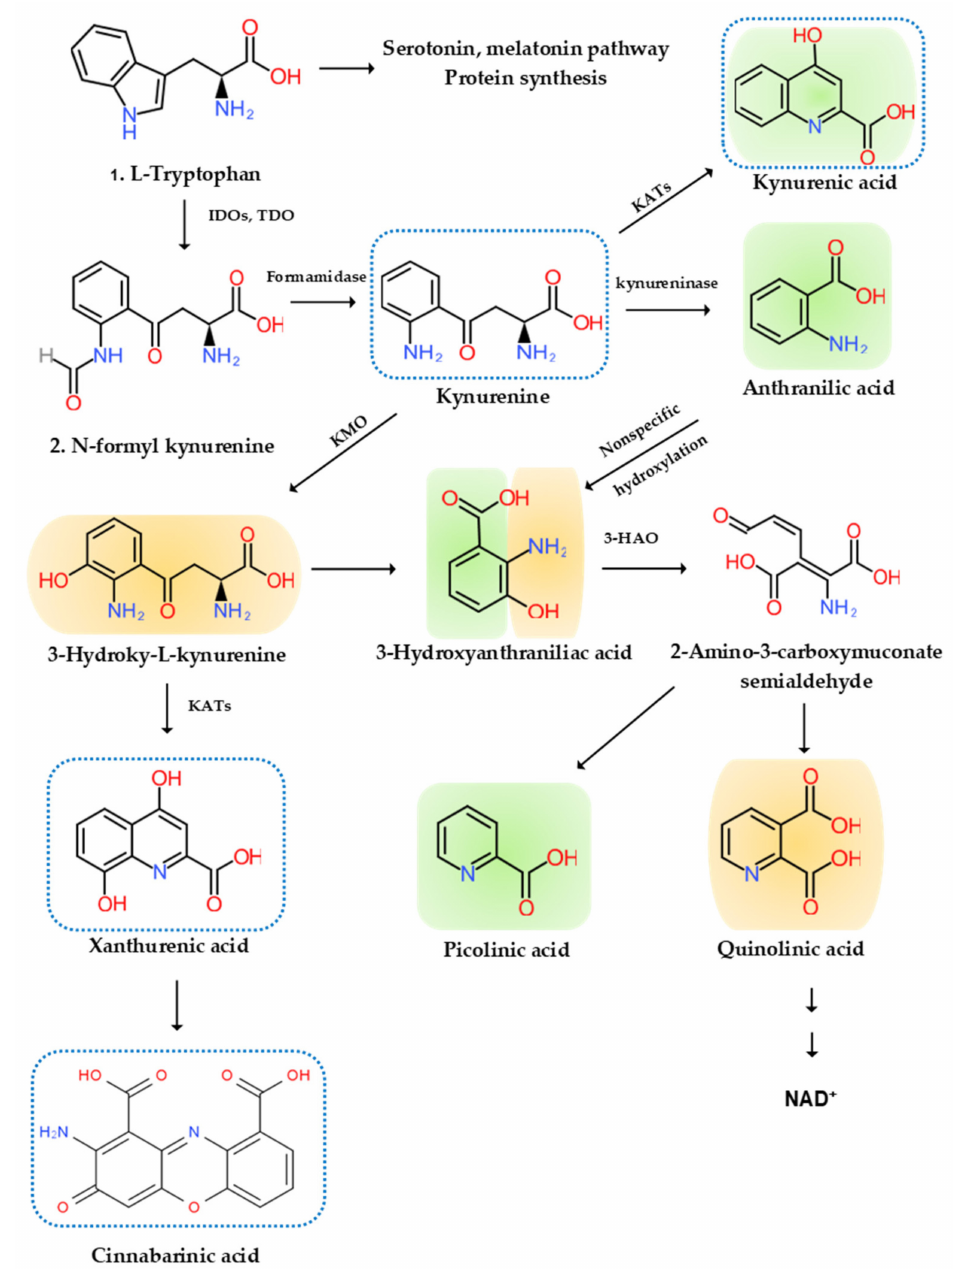
Figure 2. l -Tryptophan metabolism and the kynurenine pathway. The indole ring of l -tryptophan (TRP) is oxidized by the TRP dioxygenase (TDO) and the indolamine-2,3-dioxygenase (IDO) to produce N -formyl kynurenine (KYN). N -formyl KYN is converted by the formamidase to KYN, a substrate of three downstream metabolites: anthranilic acid (AA) by the kynureninase, 3-hydroxy-KYN (3-HK) by the KYN-3-monooxygenase (KMO), and kynurenic acid (KYNA) by KYN aminotransferases (KATs), which also convert 3-HK to xanthurenic acid (XA). XA is converted to cinnabarinic acid (CA) by autoxidation. AA and 3-HK are converted by 3-hydroxyanthranilate oxidase to 3-hydroxy-AA (3-HAA). 3-HAA is converted by 3-hydroxyanthranilate dioxygenase to 2-amino-3-carboxymuconate semialdehyde, which is further transformed into picolinic acid (PA) and quinolinic acid (QA). QA is further converted to nicotinic acid, nicotinic acid adenine dinucleotide, and nicotinamide dinucleotide (NAD + ). Neurotoxic, oxidative KYNs are shown in orange color, neuromodulartory anti-inflammatory and antioxidant KYNs are shown in green color, and aryl hydrocarbon receptor agonists are represented by a blue dotted